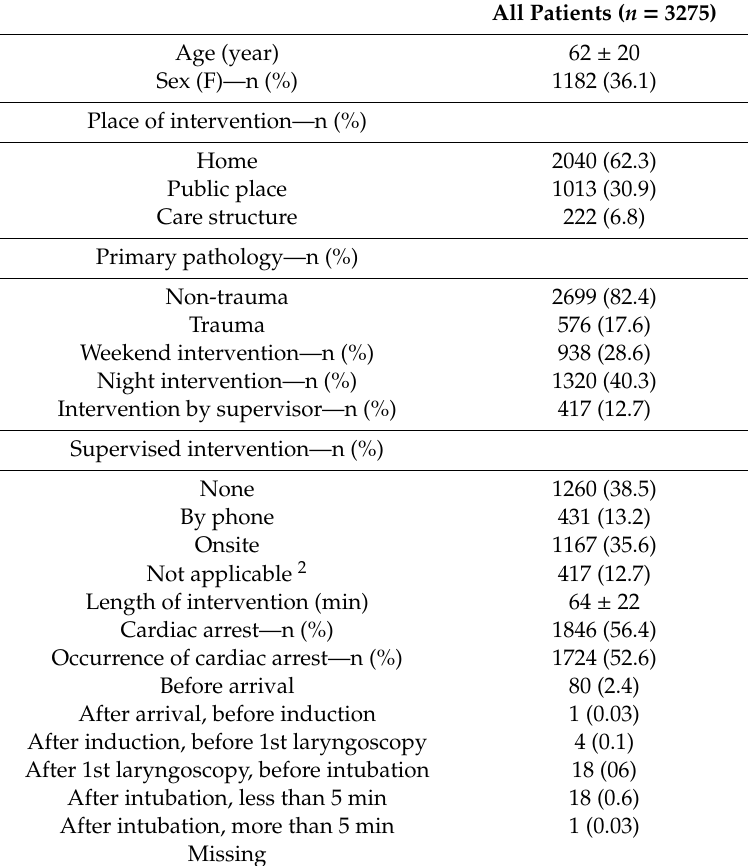
Table 1. Patient characteristics 1 .